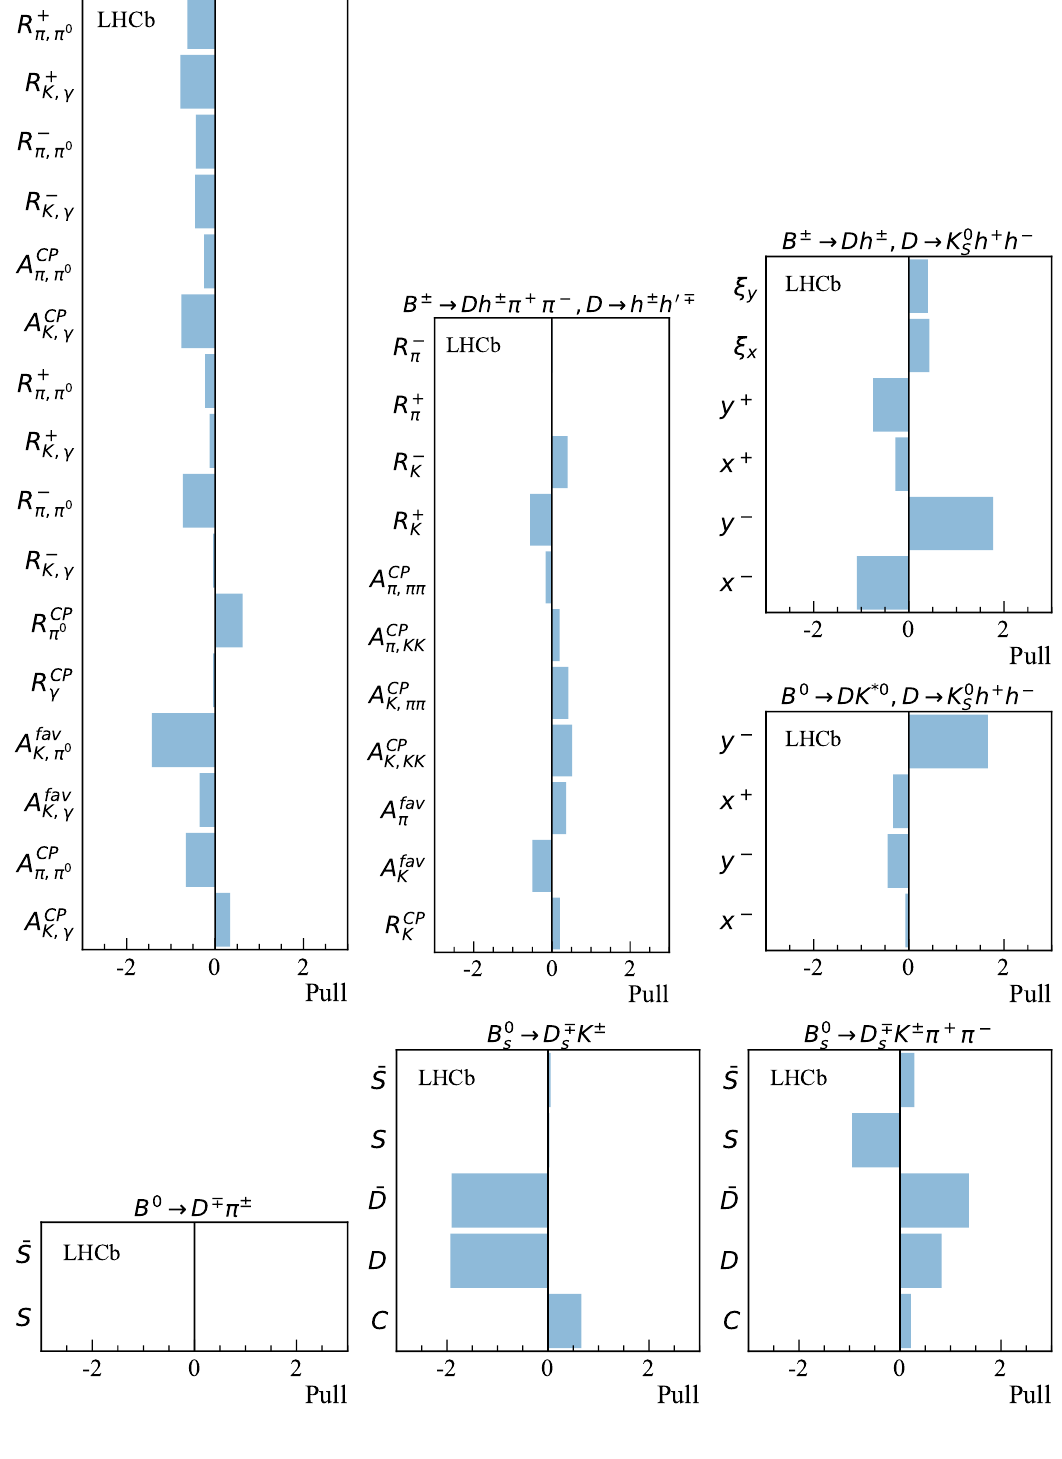
Figure 7 . Pulls of the input observables, part 2 of